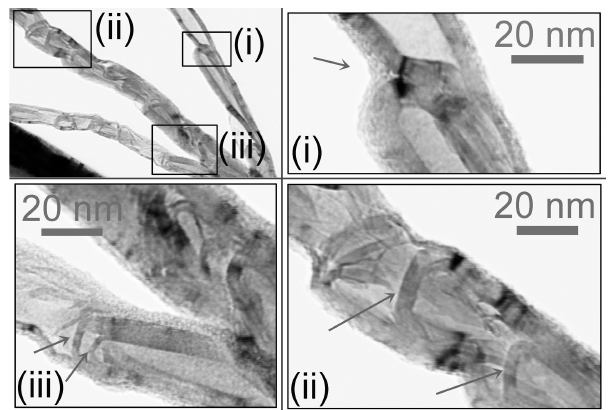
Figure 5. “Bamboo-like” CNTs are mainly produced at the lowest-temperature Region (A1 & A2, (cid:24) 800 ◦ C). The “bamboo-like” CNT consists of hollow, capped compartments along the length. Two types of compartments were observed: “off-axis” ( i.e. , the axis of the compartment is non-parallel to the main axis of the CNT) and “on-axis” ( i.e. , the axis of the compartment is parallel to the main axis of the CNT). CNT-(i) is “off-axis”; CNT-(ii and iii) are “on-axis”. The arrows indicate the